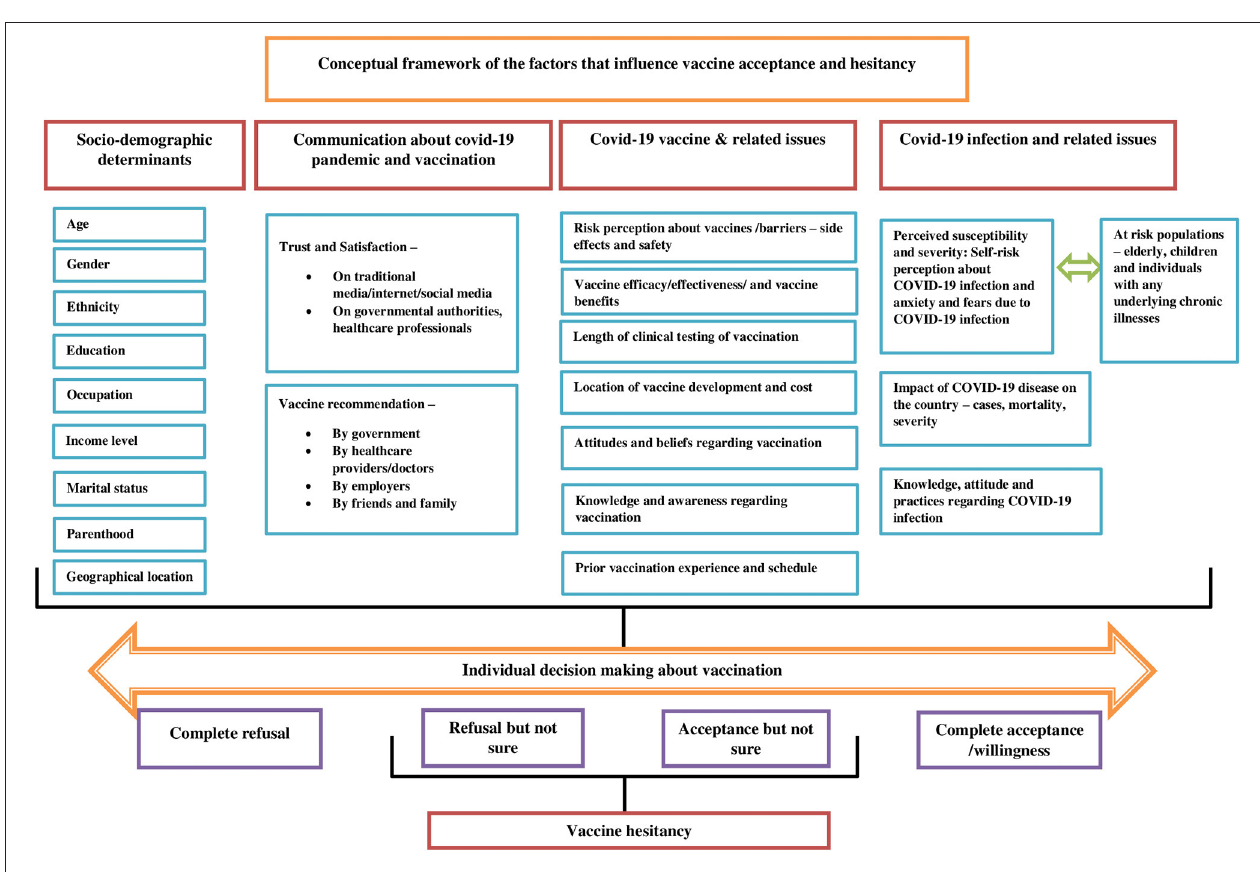
FIGURE 3 | Conceptual framework of the factors that influence vaccine acceptance and